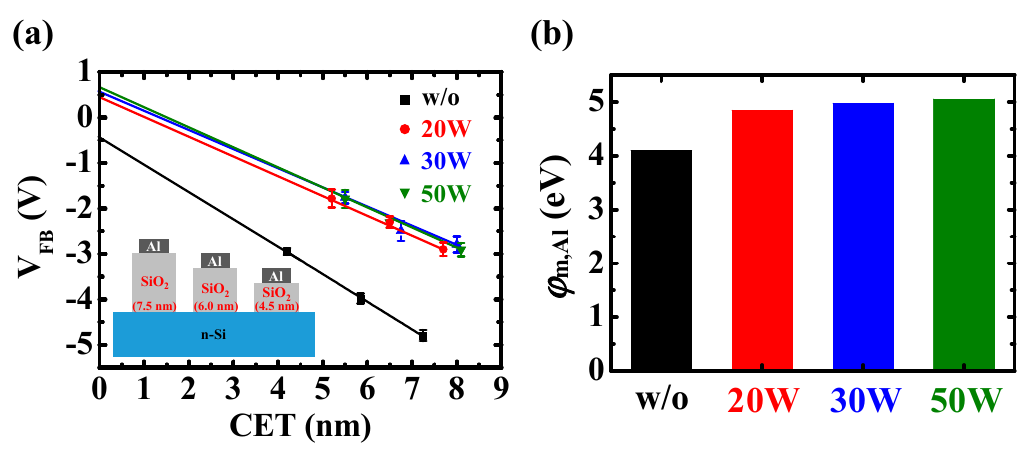
Figure 4. ( a ) Capacitance equilibrium thickness (CET) versus flat-band voltage characteristics of the Al/SiO 2 / n -Si structures with and without low-damage CF 4 plasma treatment on SiO 2 layers. The schematic Al/SiO 2 / n -Si structures of different SiO 2 film thicknesses were shown in the inset figure. The extracted effective work functions of the Al gate ( φ m,Al ) with and without low-damage CF 4 plasma treatment on SiO 2 layers were shown in ( b ).